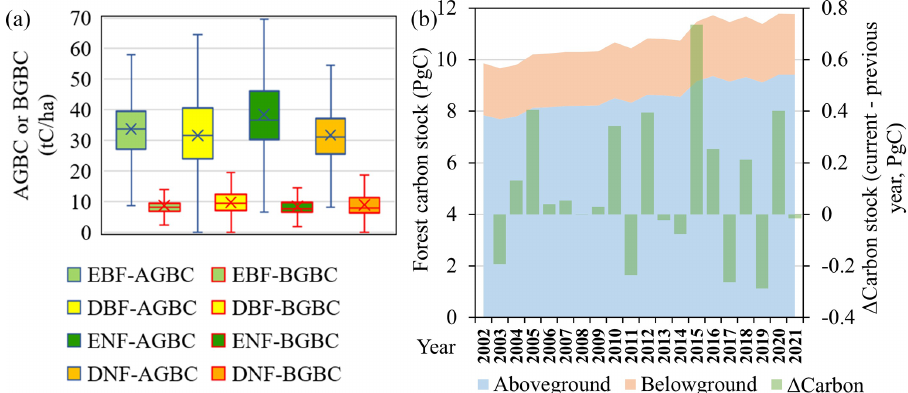
Figure 5. Forest biomass allocation and biomass change in China during 2002–2021. (a) Aboveground biomass carbon (AGBC) and below- ground biomass carbon (BGBC) density of different forest ecosystems in China. (b) The interannual changes in forest AGBC and BGBC in China. Total forest biomass carbon stock changes from the previous to the current year are represented by green